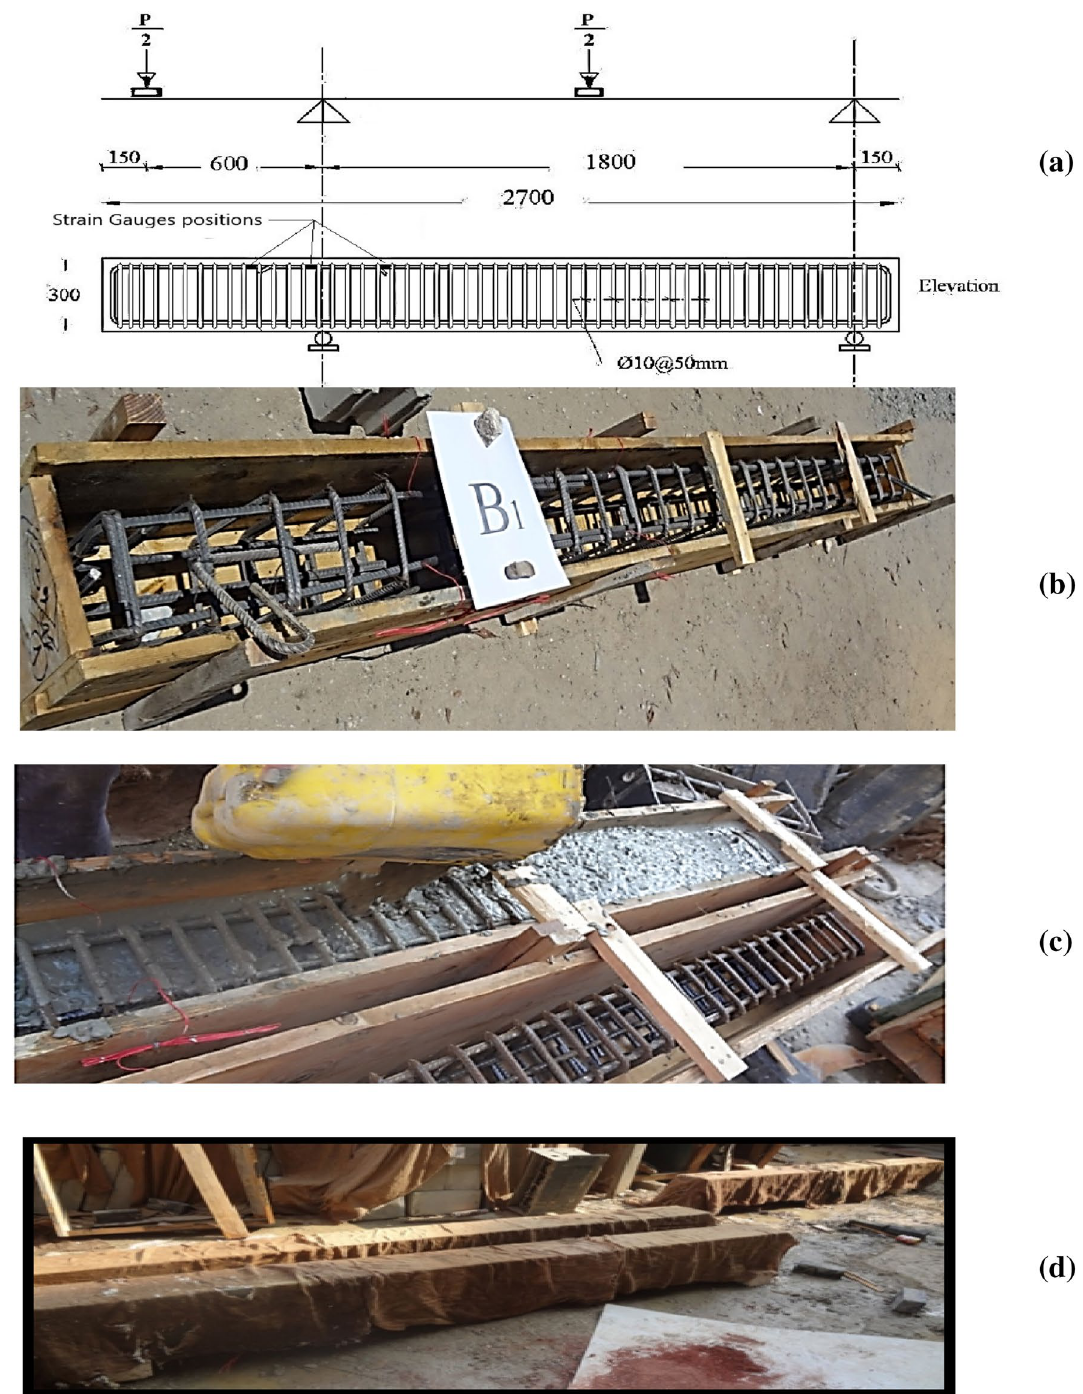
Fig. 2 a Electrical strain gauges’ locations, b and reinforcement cage, c casting a typical beam. d Curing of